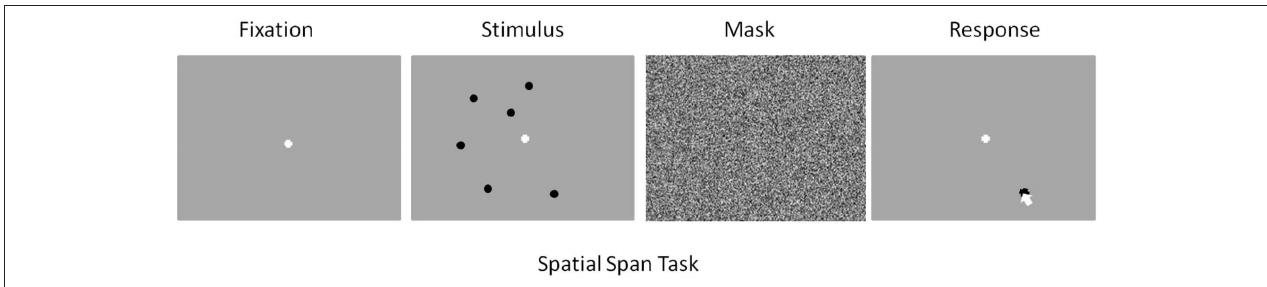
FIGURE 1 | Screenshot examples for each part of the spatial memory task in order of presentation. From left to right: Fixation (15s), Stimulus (1s), Mask (4s), Response (space bar press).